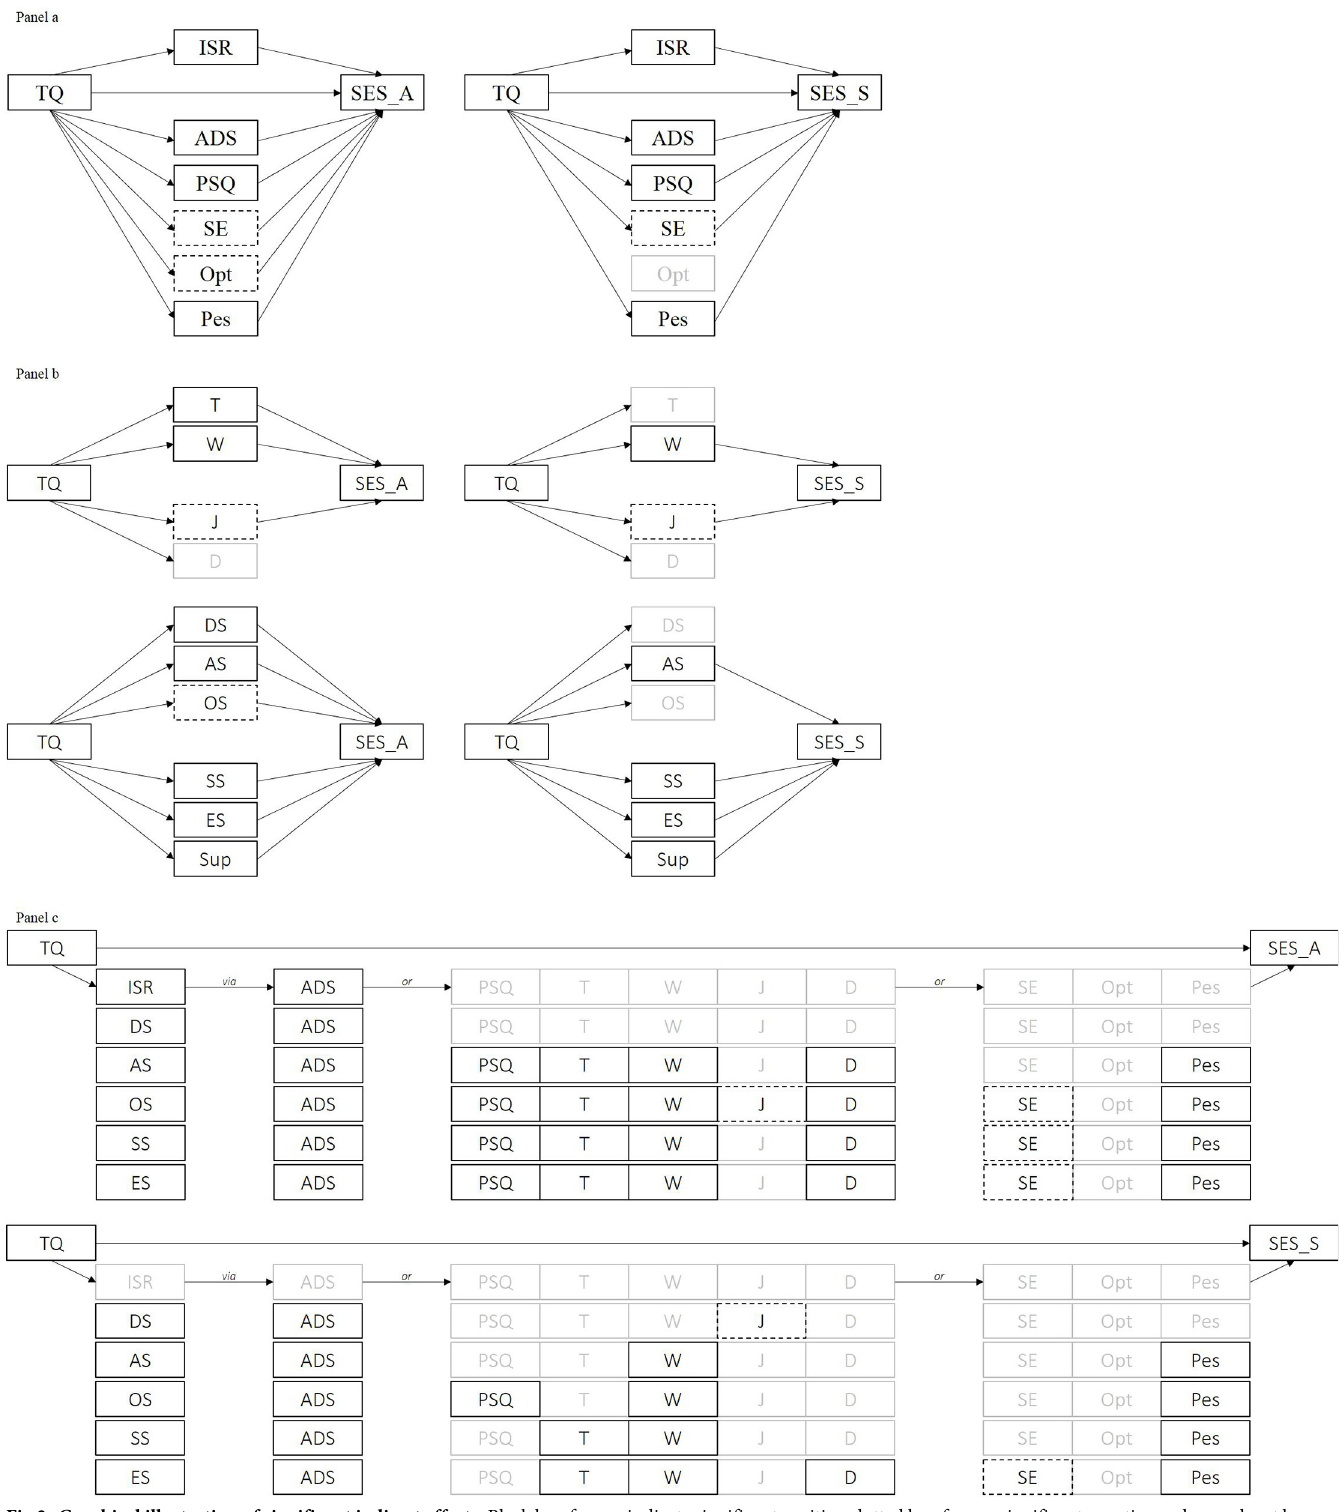
PLOS ONE | https://doi.org/10.1371/journal.pone.0234807 June 25,